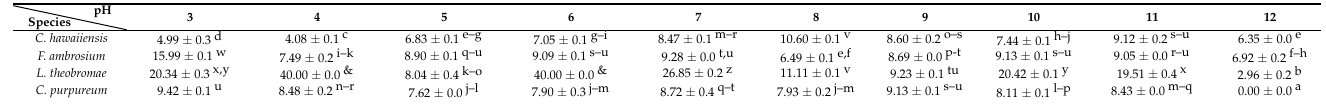
Table 3. Mycelial growth rate (mm/day) versus pH for C. hawaiiensis , F. ambrosium , L. theobromae, and C. purpureum